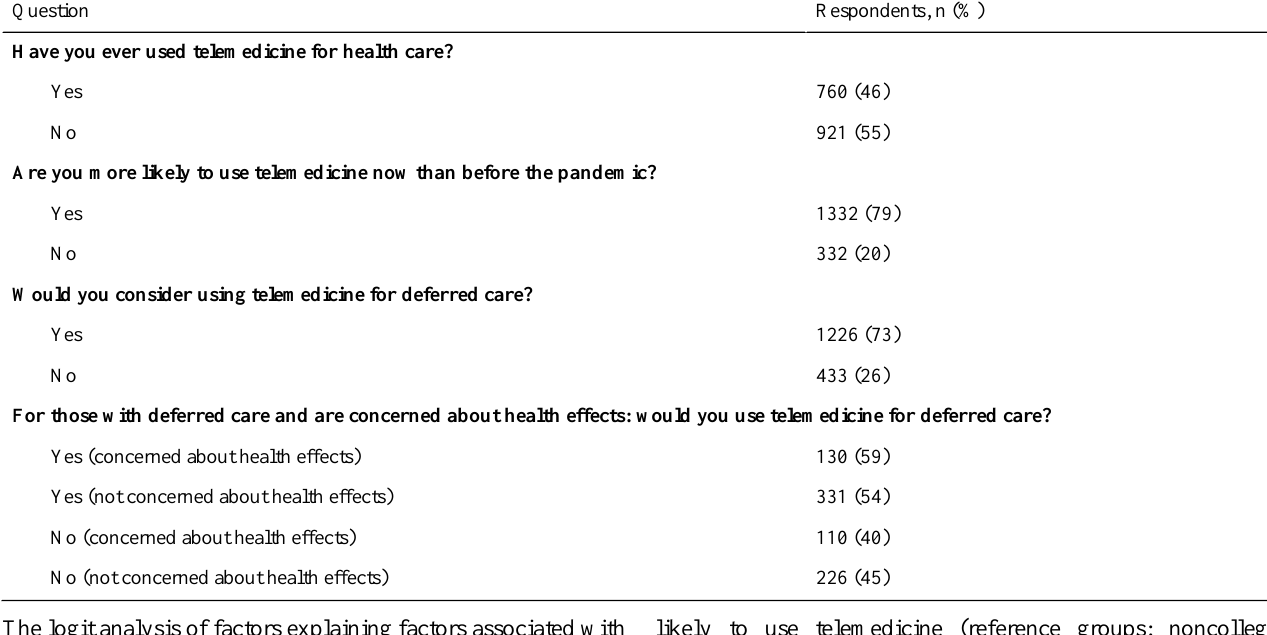
Table 5. Experience with and willingness to use telemedicine among 1861 survey respondents in Vermont between April 30 and May 13, 2020.